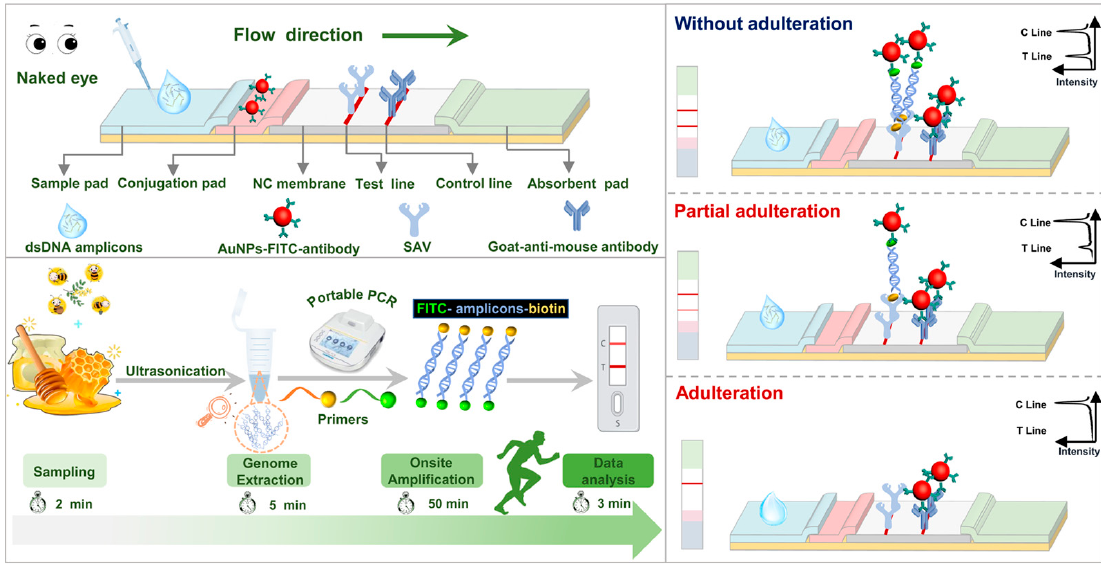
Figure 1. The schematic diagram of the rapid genetic authentication strategy for honey. The target DNA is first extracted by ultrasonication and amplified to produce the enormous functional amplicons with the designed primer set. The products of on-site amplifications were skillfully integrated with the molecular LFS and the detection results of amplicons can be easily and visually